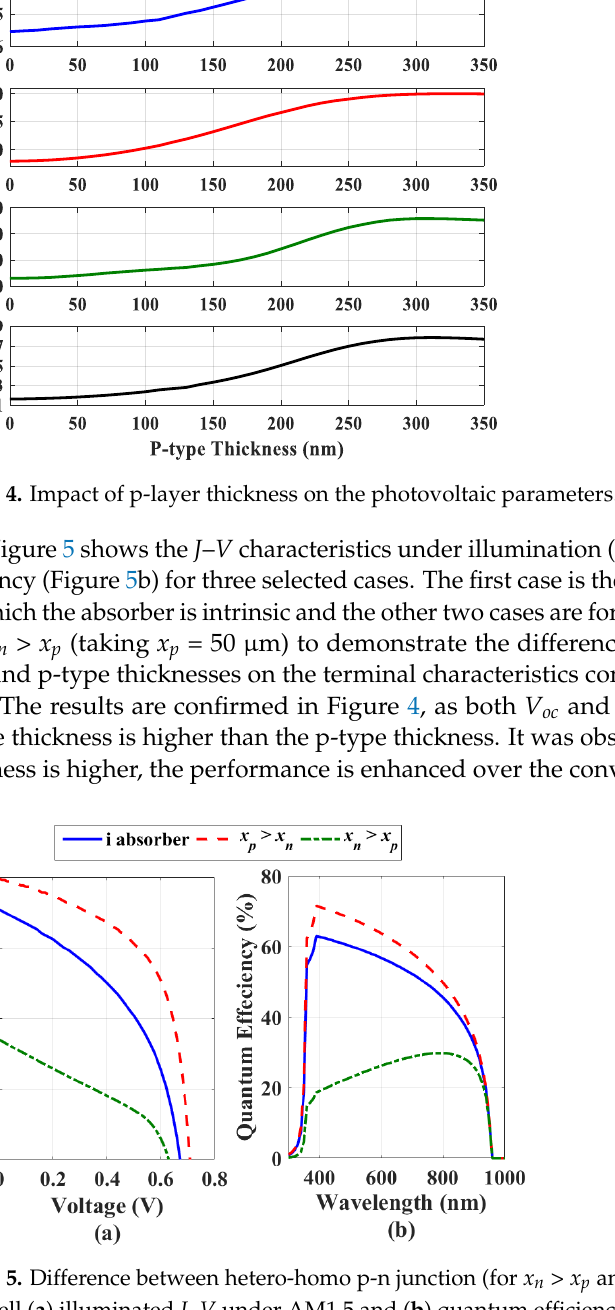
Figure 5. Difference between hetero-homo p-n junction (for x n > x p and x p > x n ) vs conventional pin solar cell ( a ) illuminated J – V under AM1.5 and ( b ) quantum efficiency.